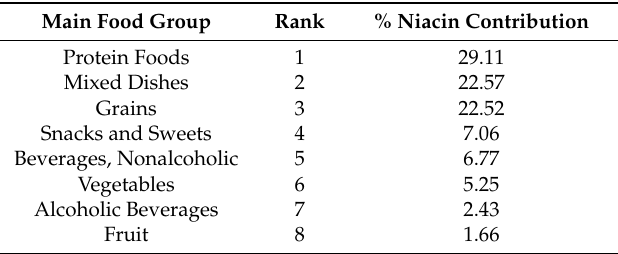
Table 18. Food sources of niacin contribution in the total U.S. diet, adults ≥ 51 years old ( n = 4522; gender combined; daily intake data; NHANES 2011–2014; main food groups contributing <1.0% not reported; data are Day 1 intakes).